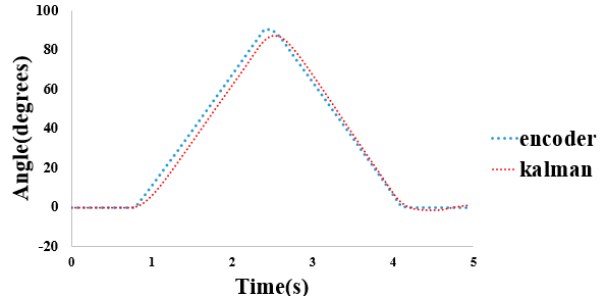
Figure 5. Comparison between estimated angles using encoder and Kalman filter.